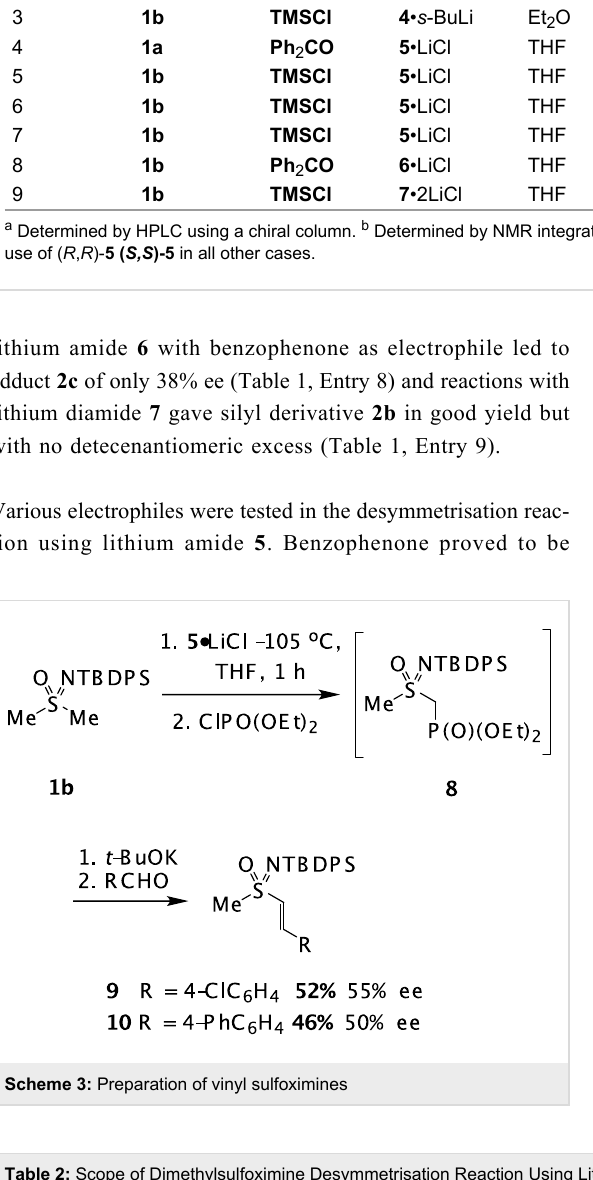
Table 2: Scope of Dimethylsulfoximine Desymmetrisation Reaction Using Lithium Amide 5 a Entry